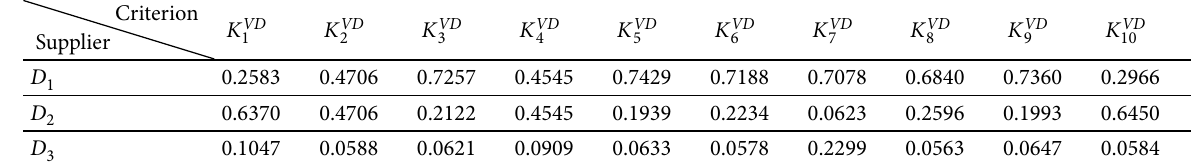
Table 7. Matrix of weight of each p suppliers due to each K criteria